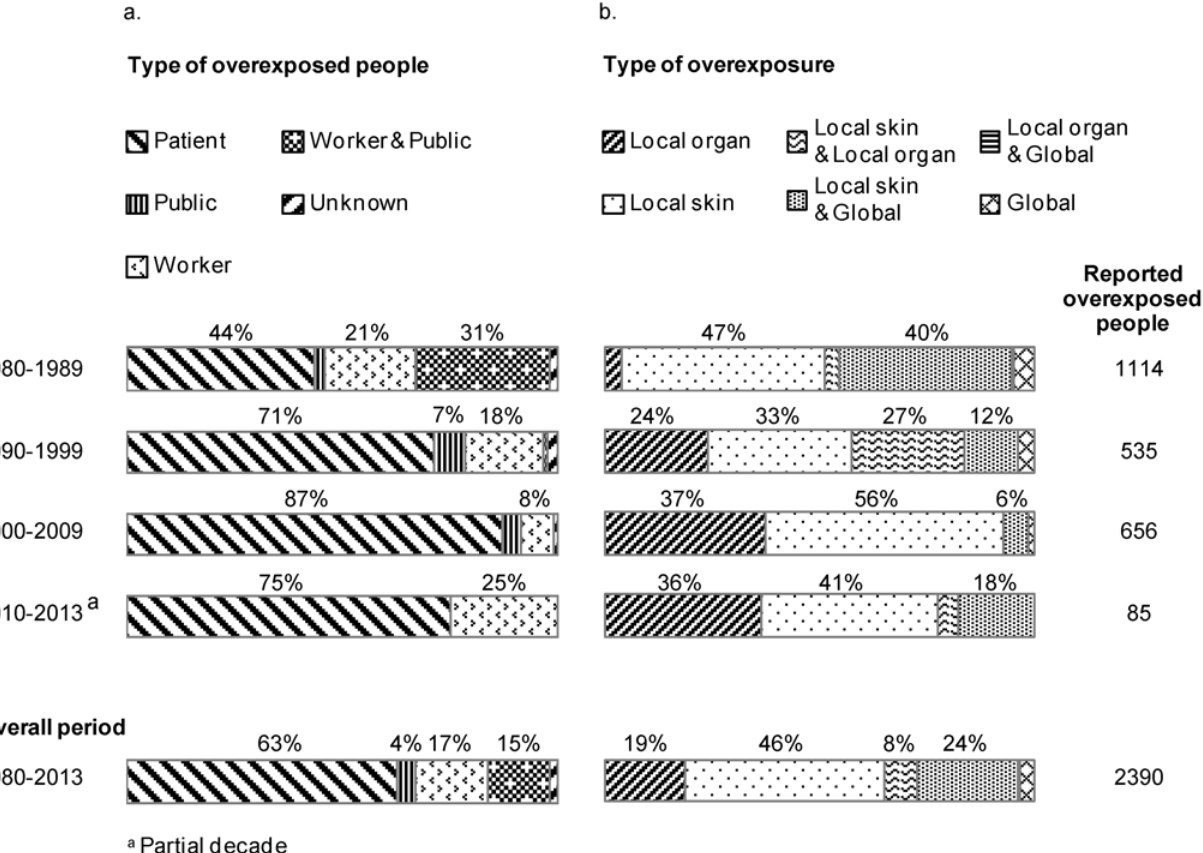
Fig 3. Evolution of type of overexposed people and type of injuries in reported radiation accidents worldwide, 1980 – 2013. (a) Type of overexposed people (b) Type of overexposure. a Partial